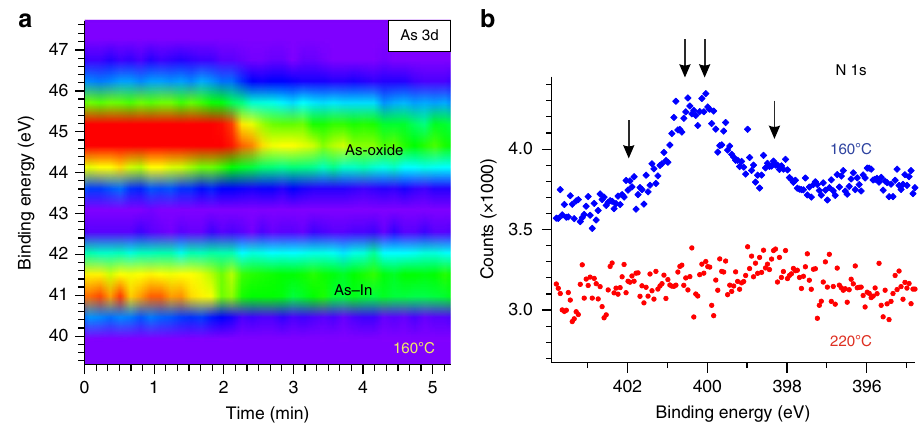
Fig. 4 Incomplete ALD reaction at low temperatures. a Time evolution of As 3d XP core level spectra during exposure to TDMA-Hf at a sample temperature of 160 °C and a gas pressure of about 2 Pa. Components corresponding to As oxide and to As bound to In are indicated. An only incomplete reduction of the oxide component can be observed. b Nitrogen (N) 1s core level spectra obtained under UHV conditions after water deposition at sample temperatures of 160 °C (blue curve) and 220°C (red curve). Separate N components are indicated by arrows. Spectra have been obtained at photon energies of 320 eV ( a ) and 530 eV ( b